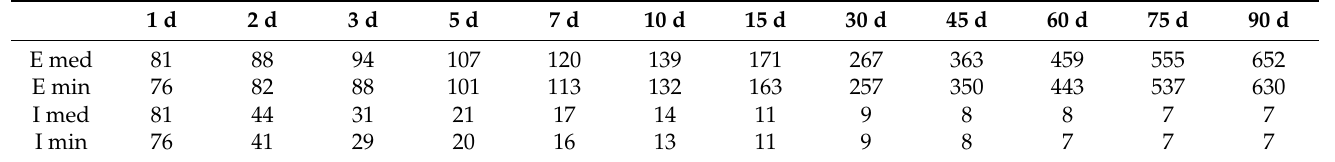
Table 8. Rainfall and intensity for the different durations considered in the thresholds of mean and lower